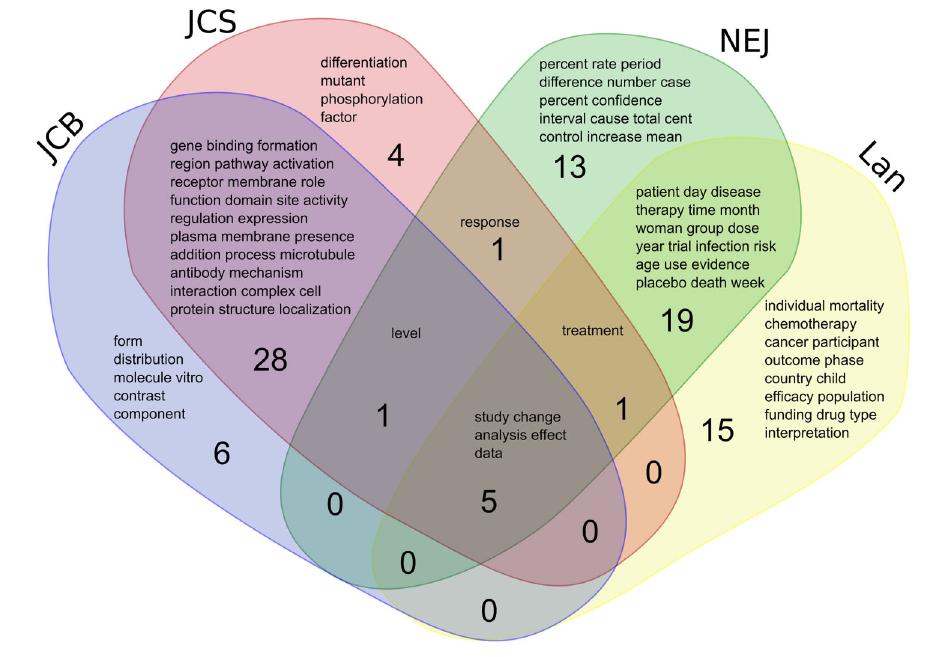
Figure 2. Distribution of highly frequent words in cell biology and medicine journals. We distributed the 40 most frequent words in titles and abstracts of articles from Journal of Cell Biology (JCB), Journal of Cell Science (JCS), New England Journal of Medicine (NEJ), and Lancet (Lan). There was a remarkable vocabulary similarity between JCB and JCS (28 shared words compared to (6 + 4) unique words), as well as between NEJ and Lan (19 shared words compared to (13 + 15) unique words). There was a large difference in vocabulary between cell biology and medicine journals, with only 5 words in